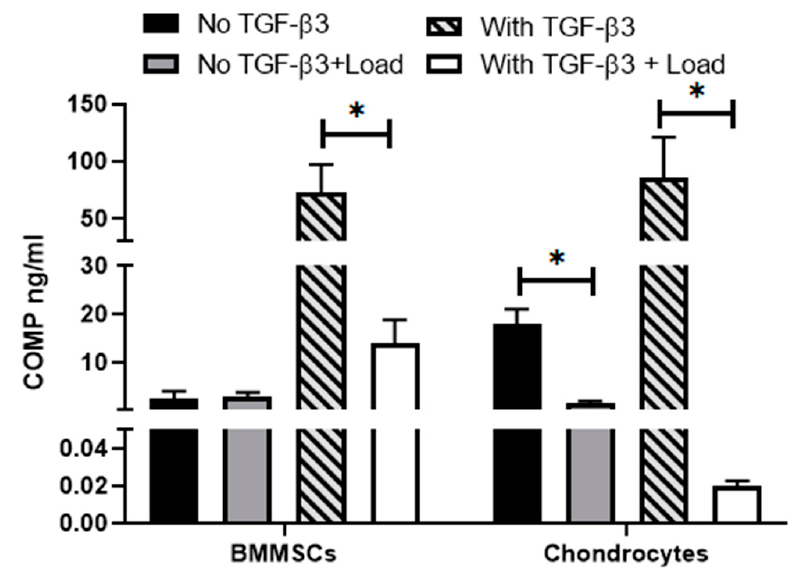
Figure 7. The release of oligomeric matrix protein (COMP) by the BMMSCs and chondrocytes encapsulated into the CS-Tyr/Gel hydrogel. The levels of secreted COMP after the chondrogenic differentiation for 21 days with/without mechanical load. Data are shown as mean ± SD, n = 3 from not less than three different cultures of each type and are significant at * p ≤ 0.05. The cells were cultivated in chondrogenic medium with or without TGF β 3 and mechanical load.